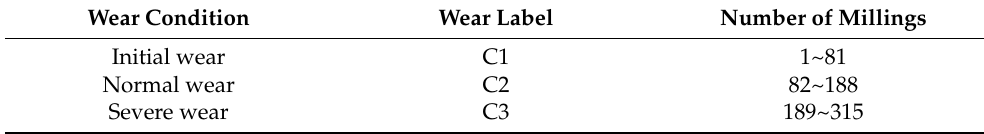
Figure 3. The change curve of the milling tool average wear in the sixth experiment [43]. Table 2. The standard of milling tool wear condition division in the sixth experiment.